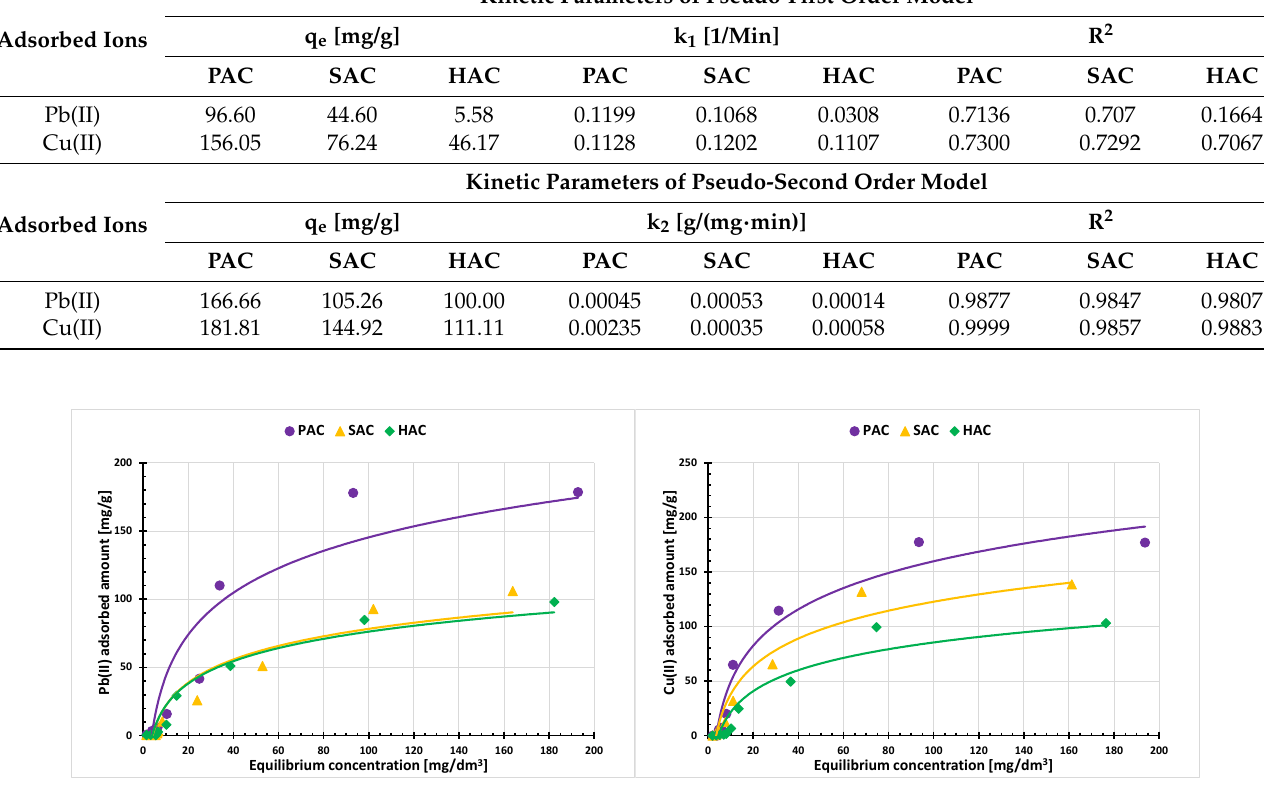
Figure 5. Adsorption isotherms of Pb(II) and Cu(II) ions on the examined solids. Table 5. Adsorption parameters obtained for modelling of heavy metal ions isotherms on the exam- ined solids surface; pH 5.